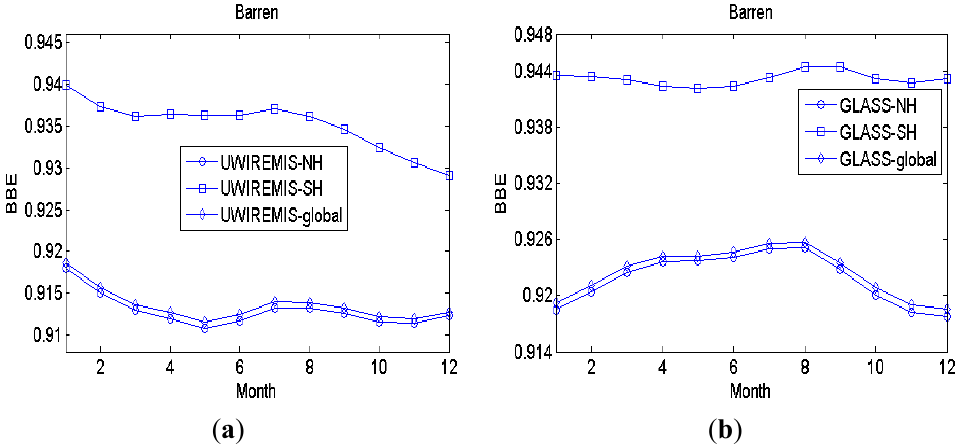
Figure 7. Monthly mean BBE of barren calculated from UWIREMIS BBE ( a ) and GLASS BBE ( b ) for global, North Hemisphere (NH) and South Hemisphere (SH),